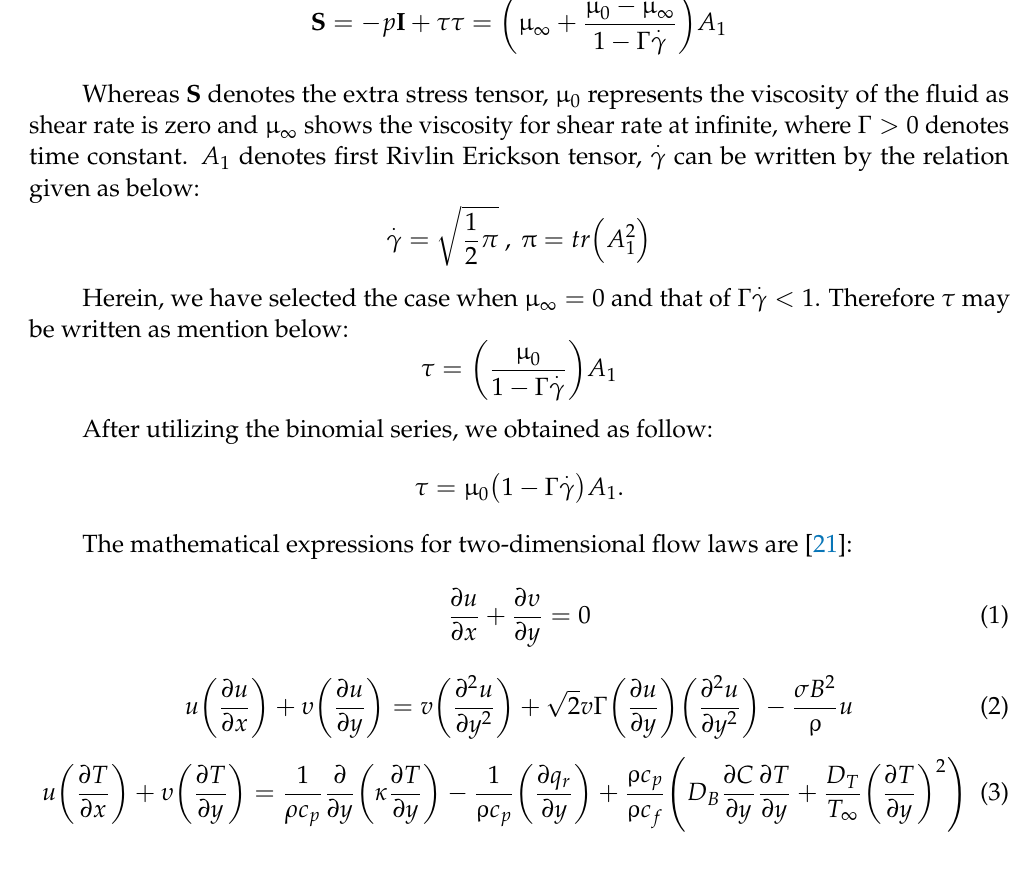
Figure 1. Schematic flow and Coordinate system. Cauchy stress tensor